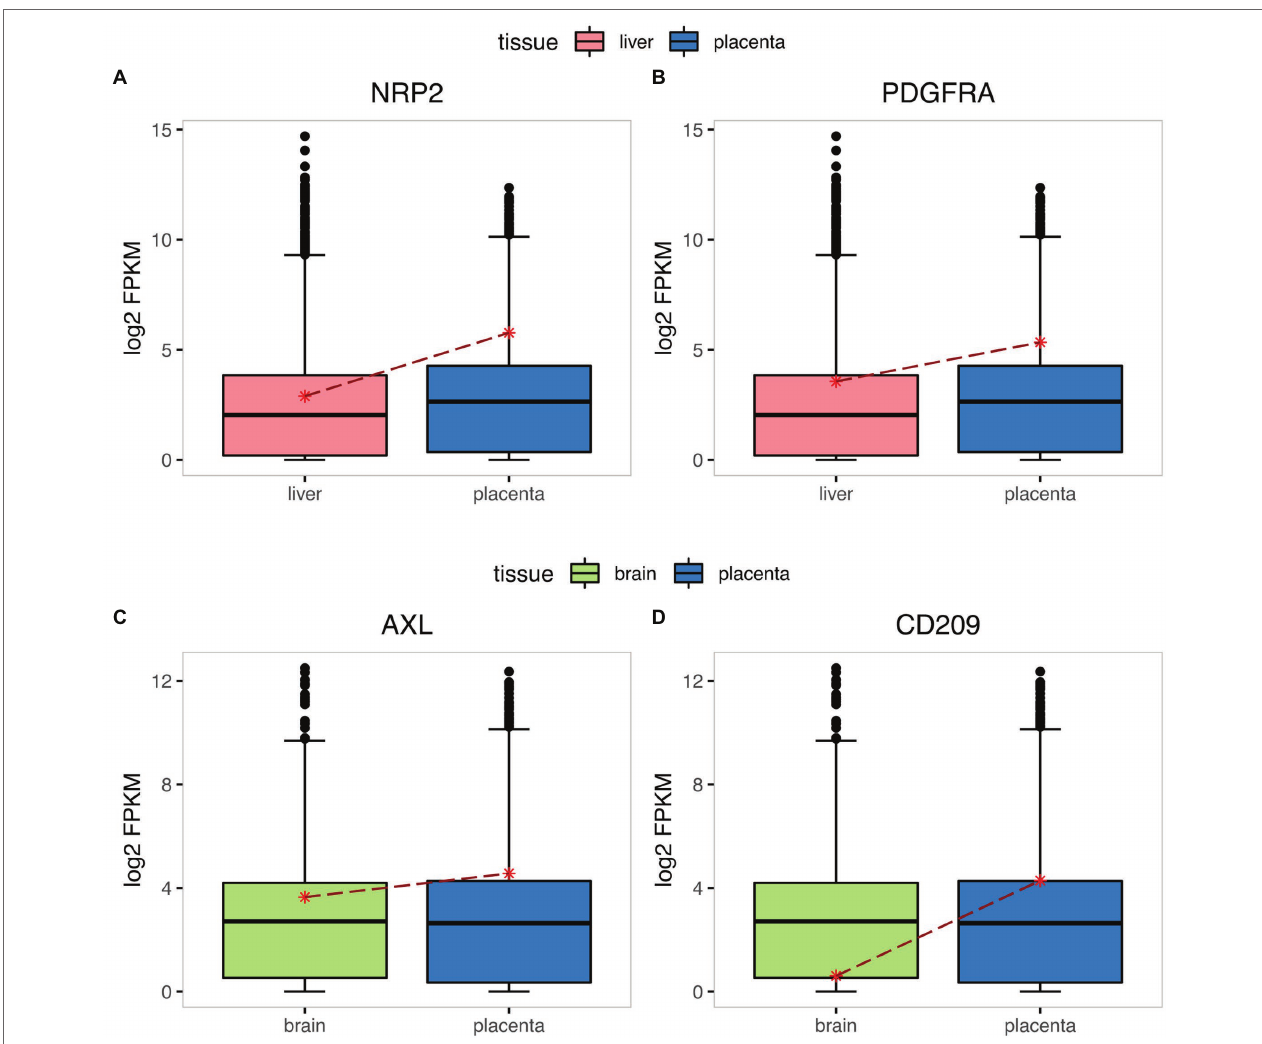
FIGURE 1 | The expression of CMV and ZIKV infection-associated factors in targeted tissues and placenta. The boxplot represents the expression level of CMV infection-associated factors NRP2 (A) , PDGFRA (B) in the liver and placenta, and ZIKV infection-associated factors AXL (C) , and CD209 (D) in the brain and placenta, the asterisk marks the mean expression level of genes. The y-axis indicates the normalized expression (log2-transformed FPKM + 1) of genes. FPKM, Fragments Per Kilobase of exon model per Million mapped